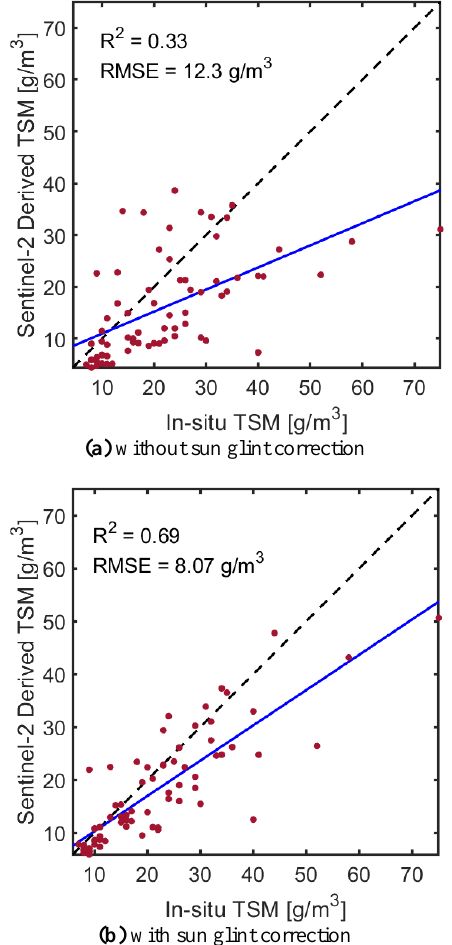
Figure 5 . Matchup validation of OBRA-based TSM retrieval to assess the temporal transferability of the model (a) without and (b) with sun glint